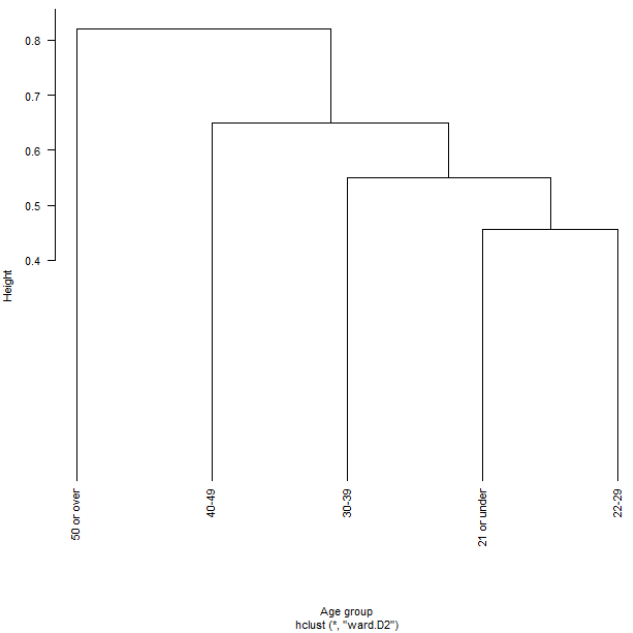
Figure A5. Dendrogram of the engagement variable of all age